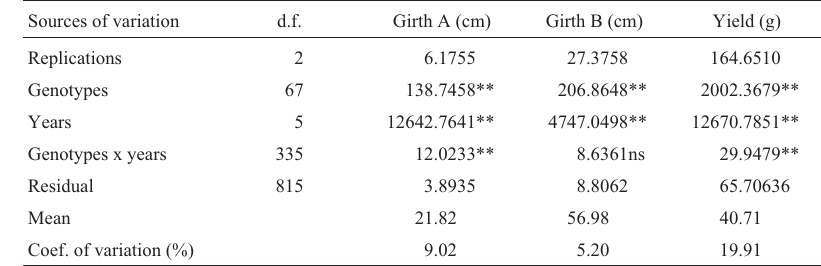
Table 1 - Analysis of variance for immature girth ages (girth A), girth mature ages (girth B) and rubber production (yield) for 68 Hevea genotypes (clones) grown in Votuporanga, São Paulo State,